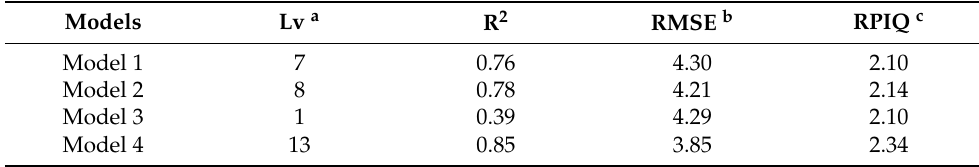
Table 4. Prediction accuracy of the SOM validation set using different